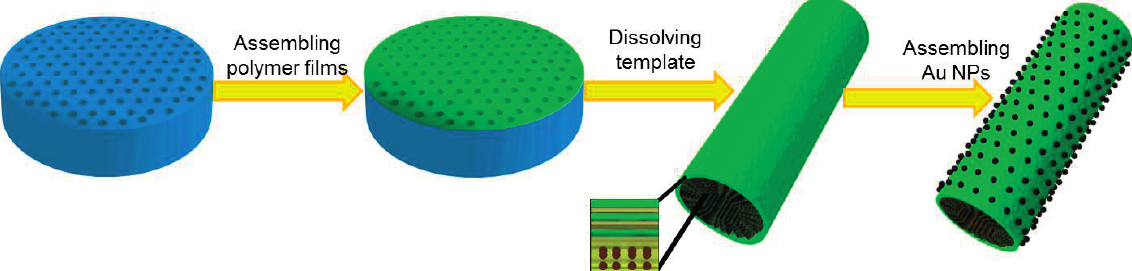
-Fe O NPs 14.5 3 4